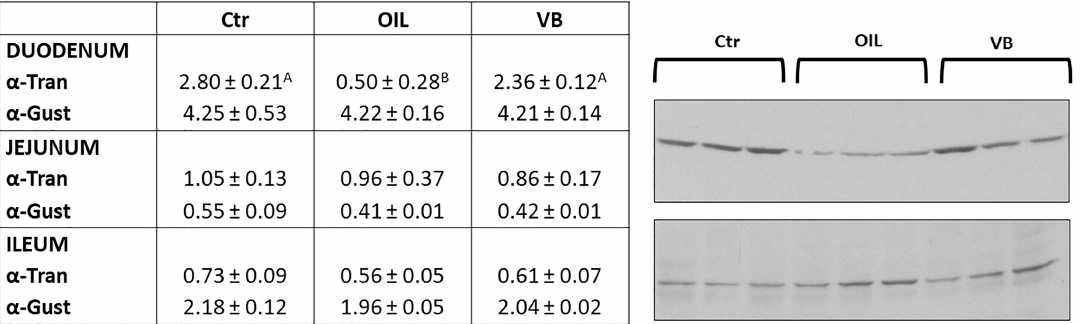
Figure 4. Western blot findings of α‐ tran and α‐ gust in the small intestine of CTR, T1 and T2 animals. The values are shown with different superscripts ( a , b ) for p < 0.05 and (A, B) for p < 0.01.